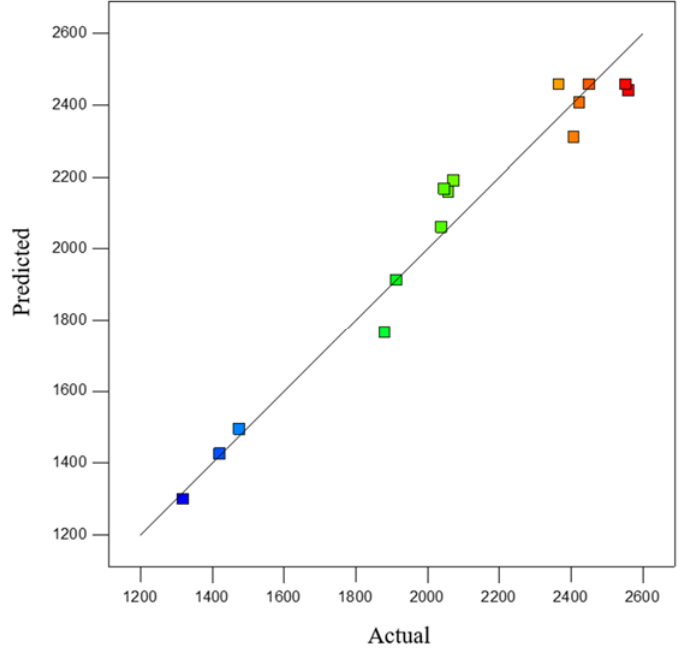
Figure 16. Relationship between experimental values of compressive strength of pellets and predicted values.